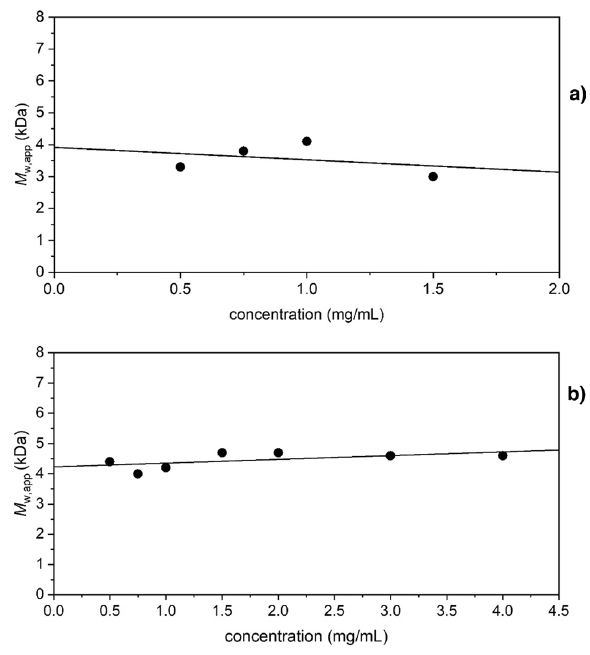
Figure 5. Dependence of apparent M w,app on concentration, with an extrapolation to obtain the thermodynamically ideal M w,app . Analysed with SEDFIT-MSTAR using the M * derived method to obtain the shown M w,app values. Rotor speed = 45,000 rpm. ( a ) TPA6 in isopropanol, M w = (3.9 ± 0.8) kDa; ( b ) TPA7 in isopropanol, M w = (4.2 ± 0.2)